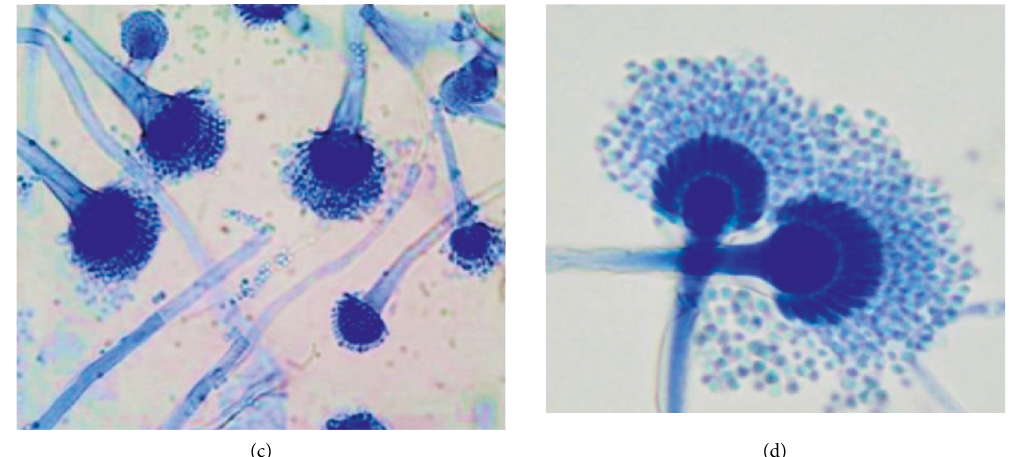
Figure 2: Microscopic results of different fungal isolates. (a) Brown rot fungi. (b) White rot fungi. (c) Aspergillus niger. (d) Aspergillus flavus. Table 2: Illustrates the weight reduction of LDPE discs in terms of percent weight loss before and after incubation with fungal isolates. Sr. no.